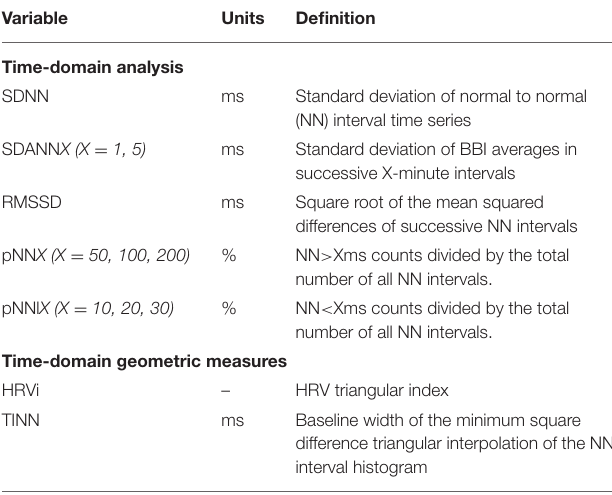
TABLE 1 | Selected time-domain HRV measures.